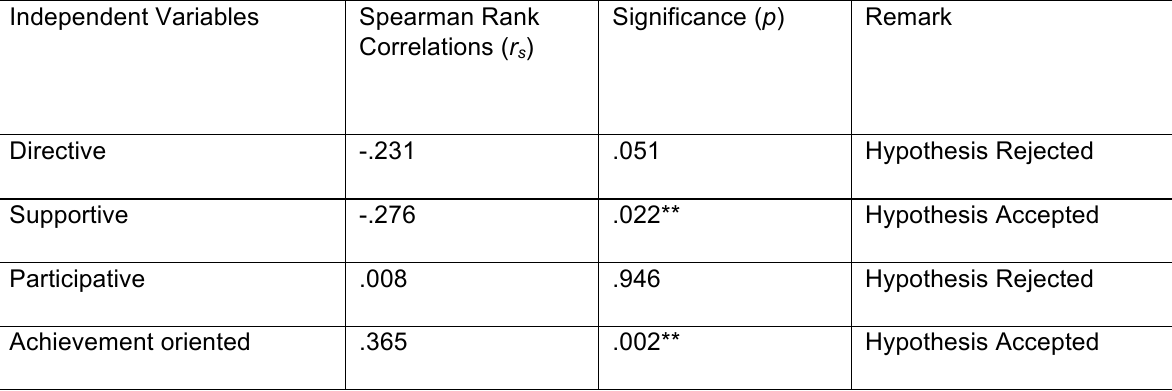
Table 4: Spearman's Rank Correlation Coefficients ( N =